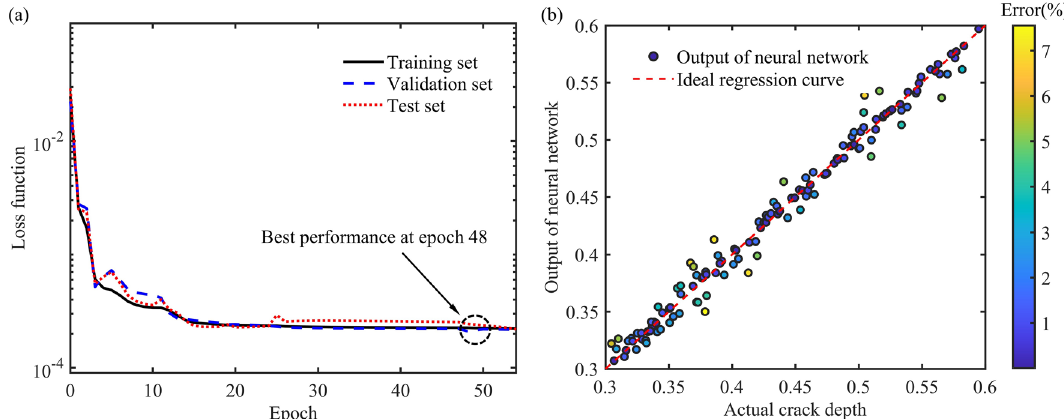
Figure 14 Training and test results of the RBF network when the crack position is uncertain: ( a ) Loss function curve, ( b ) Regression